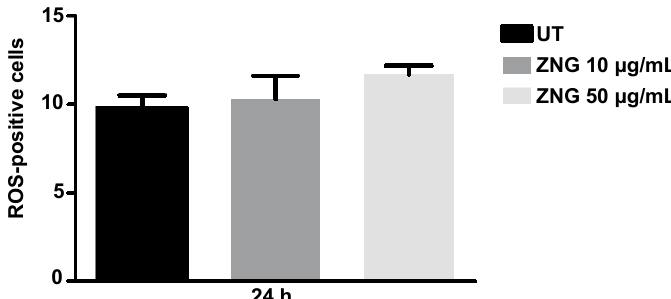
Figure 8. Intracellular ROS production of HaCaT cells after treatment with ZNGs or not (UT) for 24 h. Data are expressed as mean ± SD. Statistical analysis was performed by one-way analysis of variance (ANOVA) method coupled with the Bonferroni post-test. Values obtained are not significant.